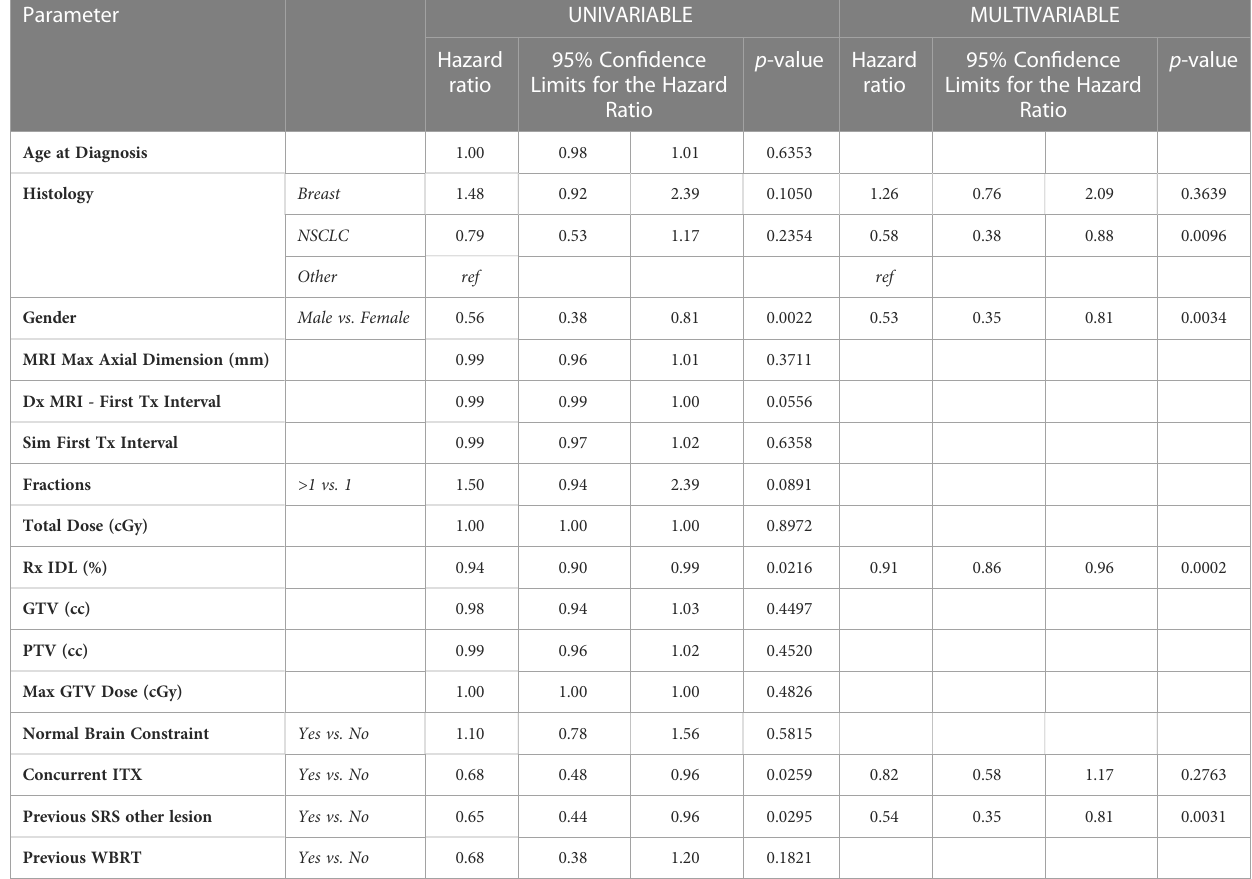
TABLE 4 Univariate and multivariable analyses for time to regional failure (distant brain